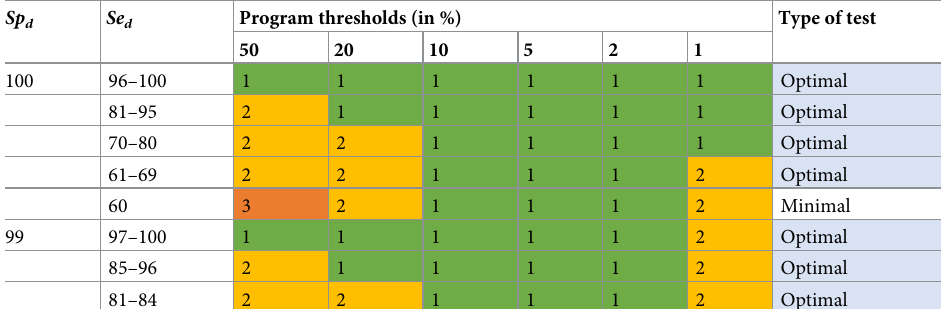
Table 2. The 61 diagnostic tests that allow for ideal decision making. The table represents the width of the grey zone around the six program decision thresholds T (1%, 2%, 5%, 10%, 20% and 50%) that allowed for a sufficient deci- sion making ( ε � 10% and ε � 5%) for each of the 61 pairs of sensitivity ( Se ) and specificity ( Sp ). For overtreat undertreat d d simplicity, we have classified the width of the grey zone into three levels (1–3) for each threshold separately. This classi- fication into 3 levels was based on the 25 th and 75 th percentile of the width of the grey zones (level 1: width of grey zone < 25 th percentile; level 2: 75 th percentile > width of grey zone � 25 th percentile; level 3: width of grey zone � 75 th percentile (see S1 Table ) across all potential diagnostic methods that allowed for adequate program decision making. In other words, each of these diagnostic methods allowed for adequate decision making ( ε overtreat is set at 25%) at a true underlying prevalence of zero). Diagnostic tests were considered ‘optimal’ (blue) when they resulted in level 1 grey zone around at least 3 out of the 6 thresholds and did not result in a level 3 grey zone in any of the 6 program thresh- olds. In all other cases, the diagnostic test was considered ‘minimal’